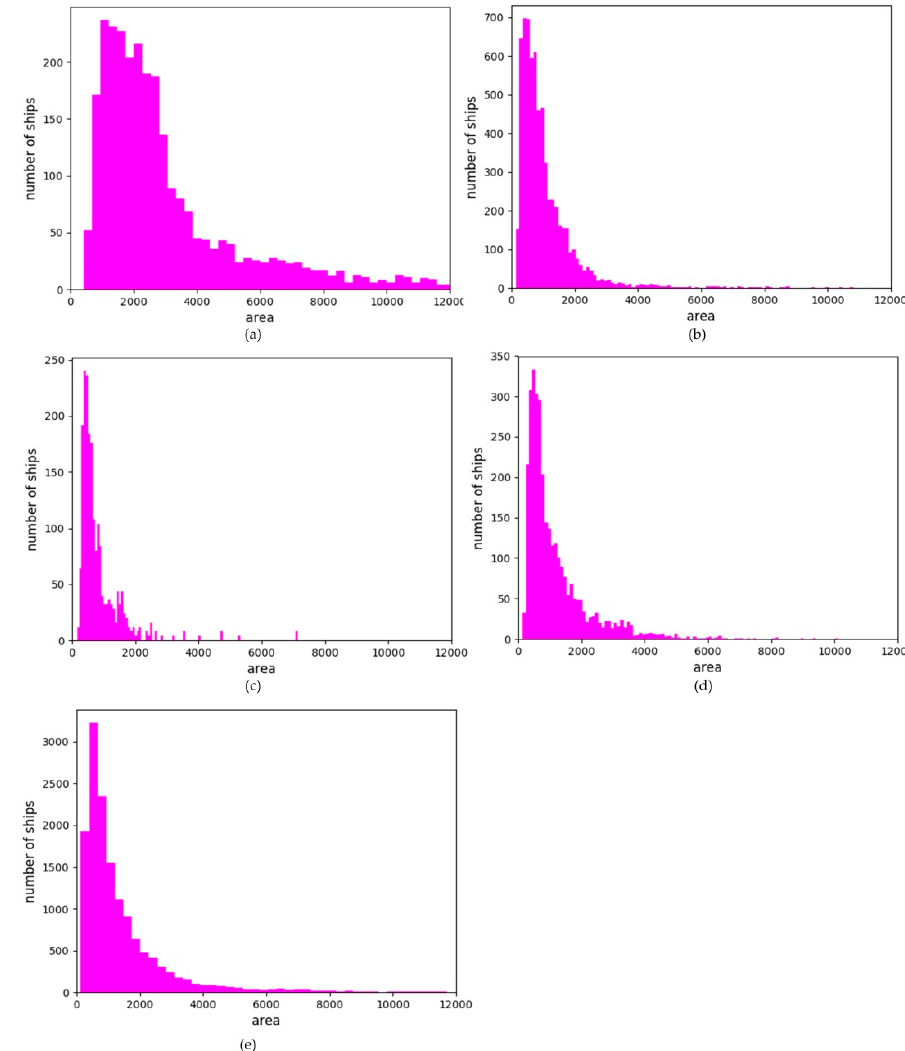
Table 7. The detailed AIS information on the 4 missing detected ships.